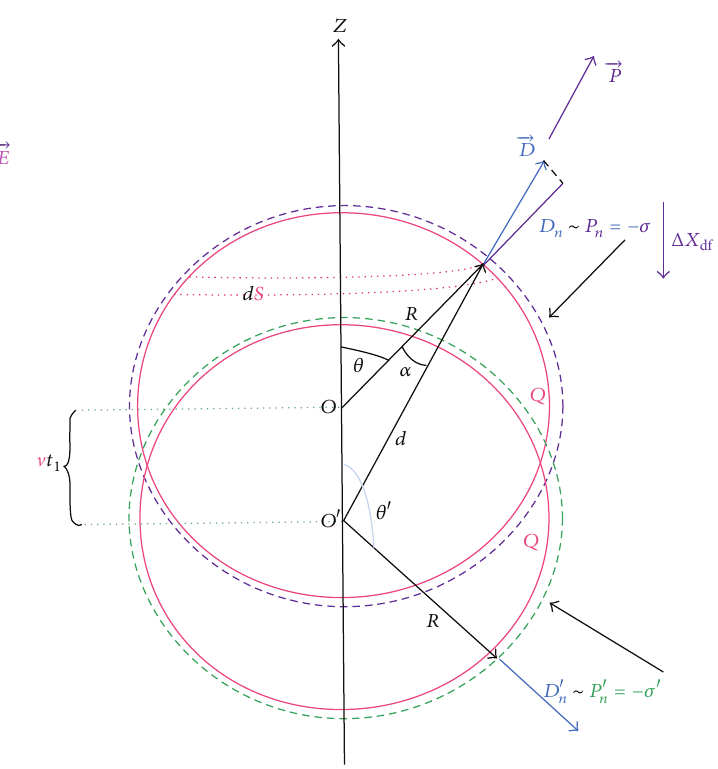
Figure 2: Representation of a moving spherical polyion at time 𝑡 and time (𝑡 − 𝑡 1 )